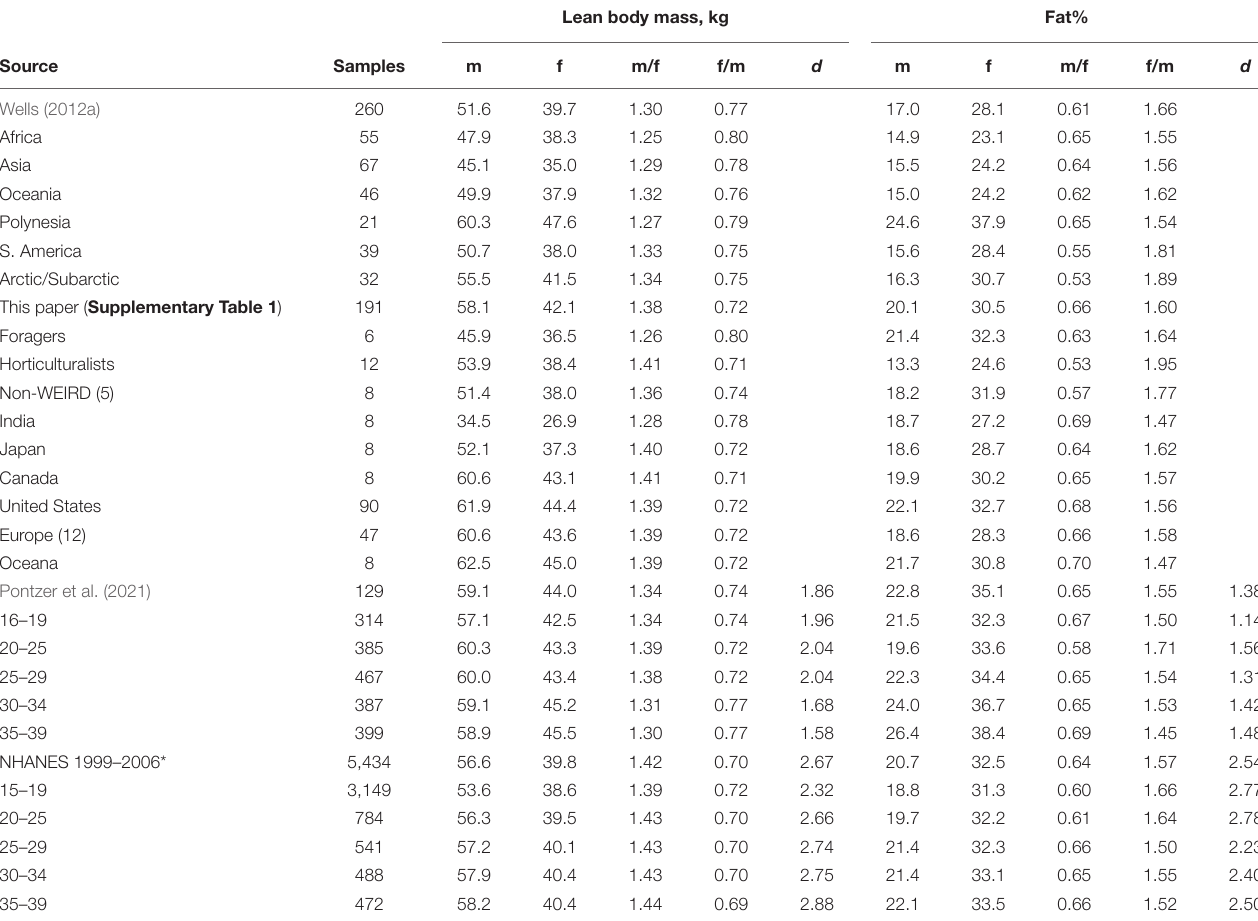
TABLE 1 | Lean body mass (kg) and percent body fat from four data sets with ratios and effect sizes ( d ) where available. Lean body mass, kg